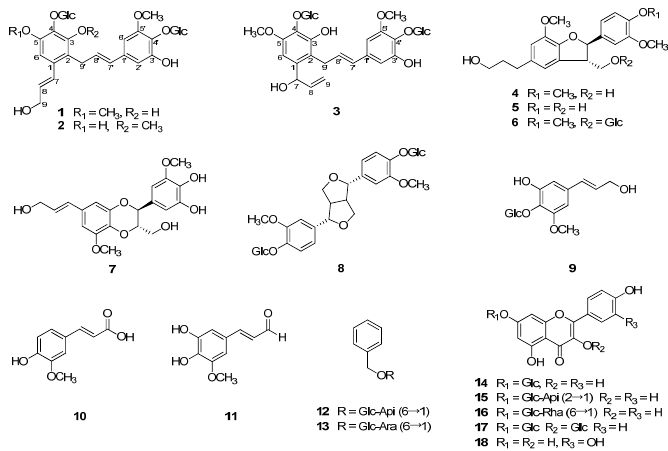
Figure 1. Structures of compounds 1 – 18 isolated from Campanula takesimana .